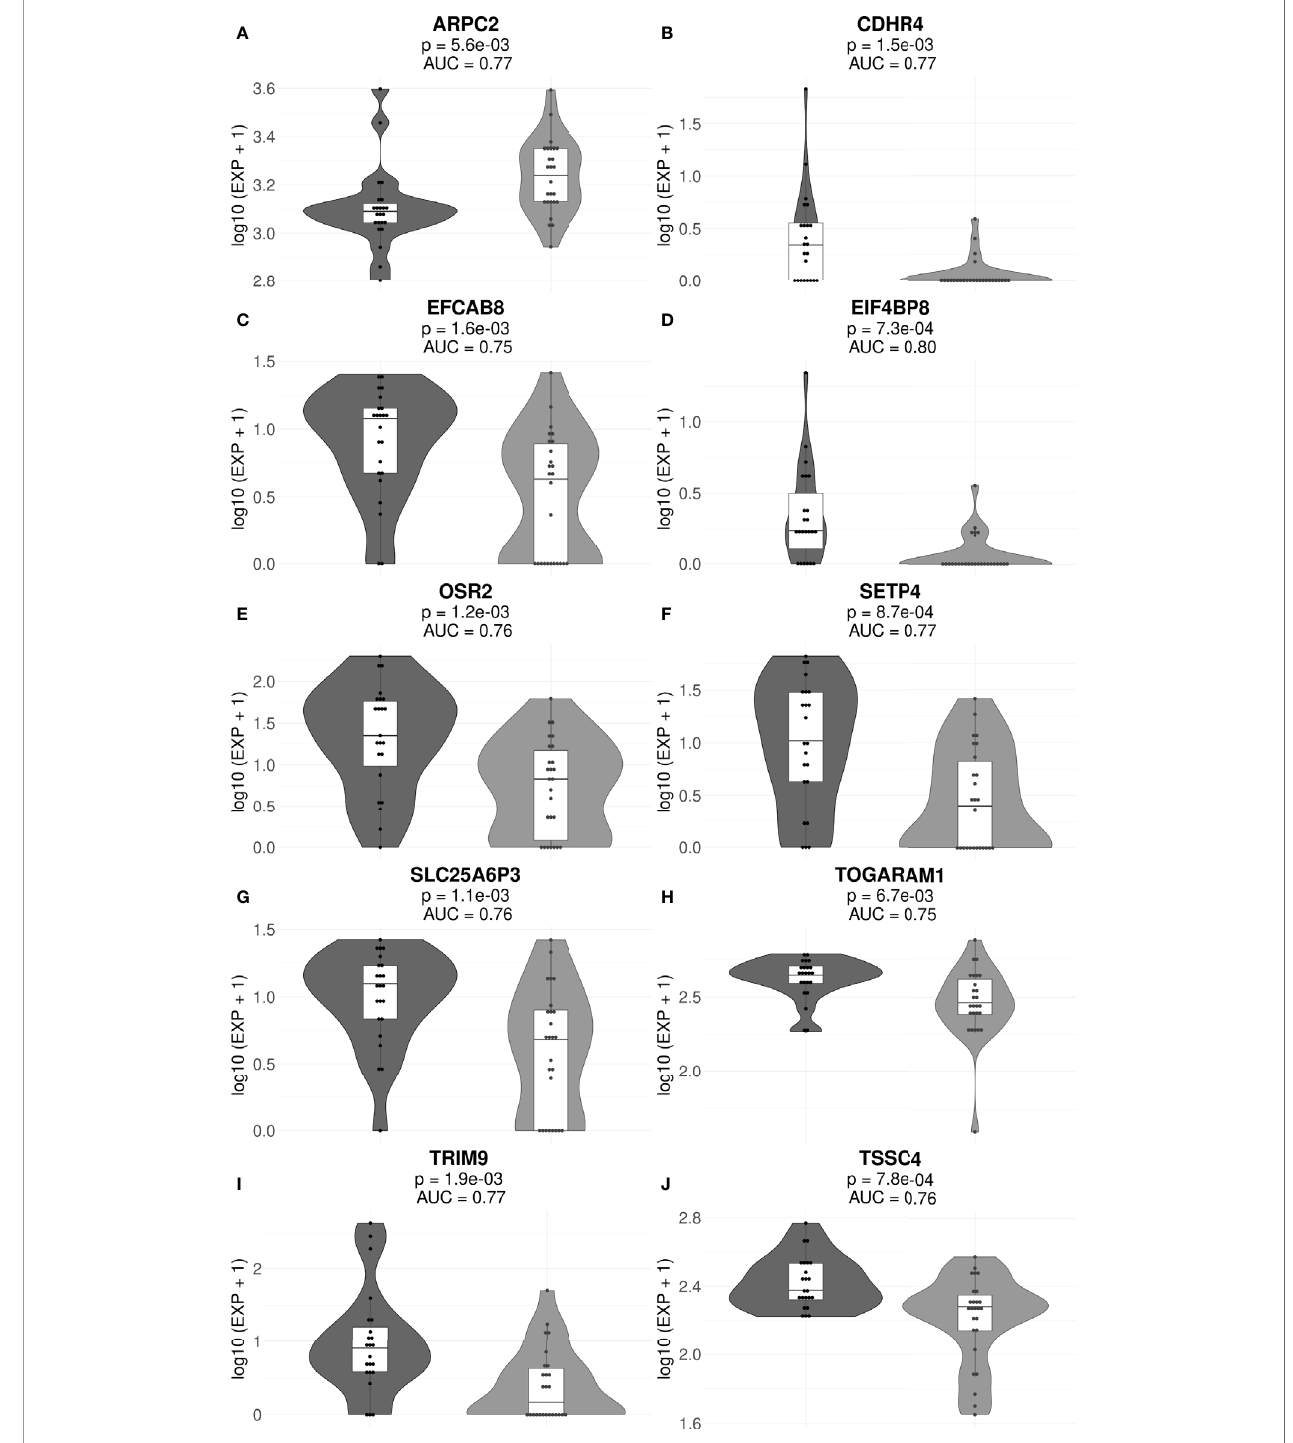
FIGURE 4 | Gene expression levels of genes ARPC2 (A) , CDHR4 (B) , EFCAB8 (C) , EIF4BP8 (D) , OSR2 (E) , SETP4 (F) , SLC25A6P3 (G) , TOGARAM1 (H) , TRIM9 (I) , and TSSC4 (J) in the cohorts of MM responders and poor responders to VCD therapy. For every gene, paired t-test p-values and AUC values are shown. Each dot on the graph represents single MM sample. Grey indicates good treatment responders, black — poor